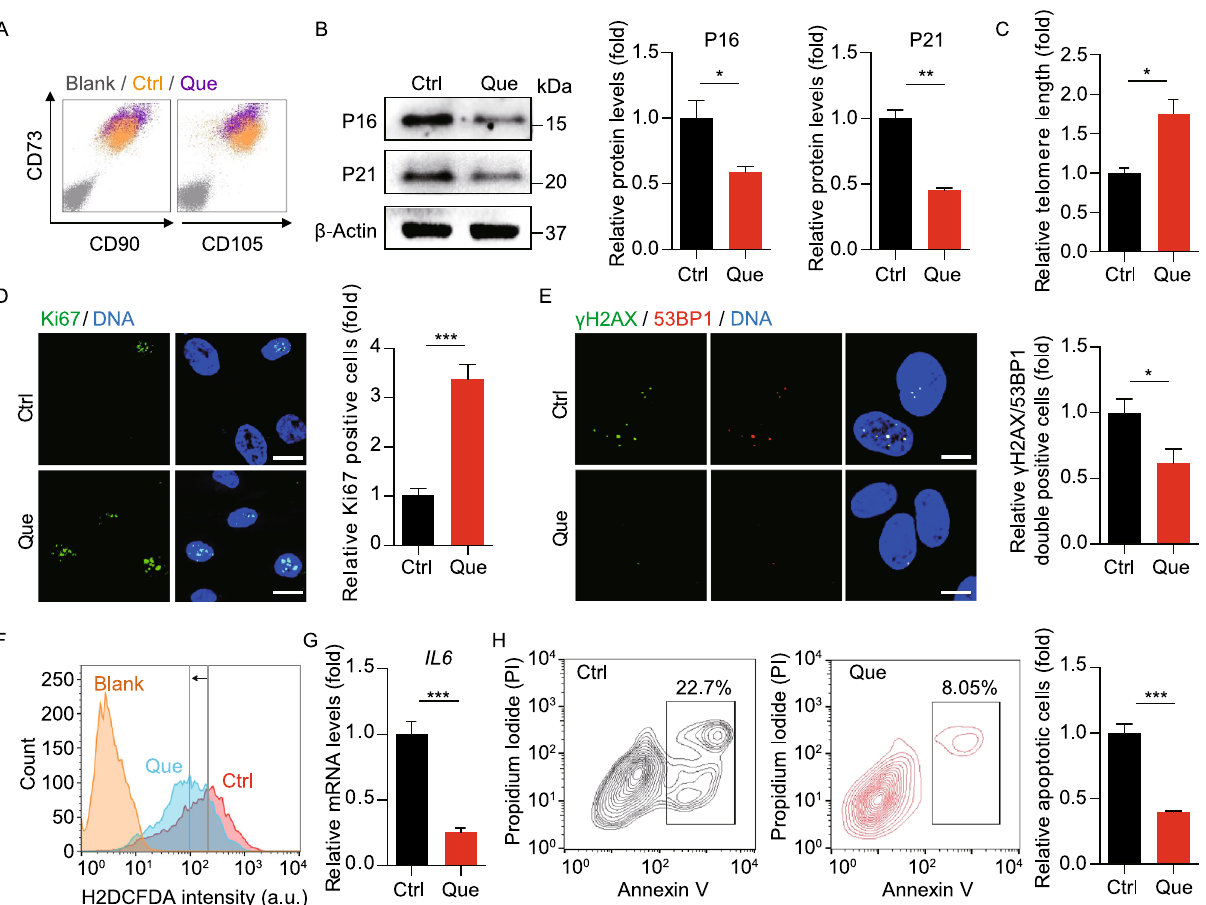
Figure 3. Que alleviated senescence and promoted self-renewal of WS hMSCs. (A) FACS analysis of hMSC-speci fi c markers (CD73, CD90 and CD105) in vehicle- and Que-treated WS hMSCs. (B) Immunoblotting analysis of aging-related markers P16 and P21 in vehicle- and Que-treated WS hMSCs (passage 7). β -Actin was used as the loading control. Data are shown as mean ± SEM ( n = 3). * P < 0.05 vs. Ctrl; ** P < 0.01 vs. Ctrl. (C) Quantitative PCR analysis of telomere length of vehicle- and Que-treated WS hMSCs (passage 7). Data are shown as mean ± SEM ( n = 3). * P < 0.05 vs. Ctrl. (D) Immunostaining of Ki67 in vehicle- and Que-treated WS hMSCs (passage 7), Scale bar, 25 μ m. Data are shown as mean ± SEM (cell number ≥ 300). *** P < 0.001 vs. Ctrl. (E) Immunostaining of γ -H2AX and 53BP1 in vehicle- and Que-treated WS hMSCs (passage 7), Scale bar, 10 μ m. The percentage of γ -H2AX/53BP1-double positive cells are shown as mean ± SEM (cell number ≥ 300). * P < 0.05 vs. Ctrl. (F) FACS measurement of reactive oxygen species (ROS) by H2DCFDA in vehicle- and Que-treated WS hMSCs (passage 7). a.u., arbitrary unit. (G) RT-qPCR analysis of IL6 mRNA levels in vehicle- and Que-treated WS hMSCs (passage 7). Data are shown as mean ± SEM ( n = 3). *** P < 0.001 vs. Ctrl. (H) Cell apoptosis assay in vehicle- and Que-treated WS hMSCs (passage 7). Quantitative data on the right are presented as mean ± SEM ( n = 3). *** P < 0.001 vs.